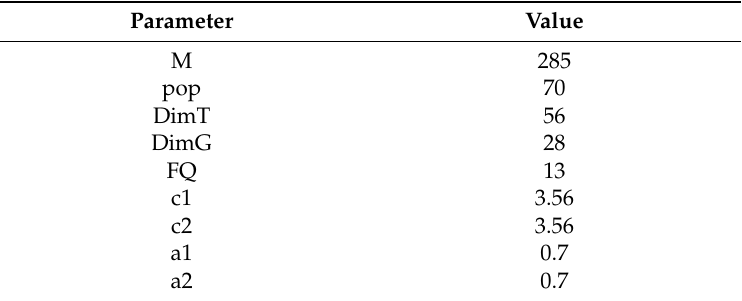
Table 3. Parameters of the best experiment.